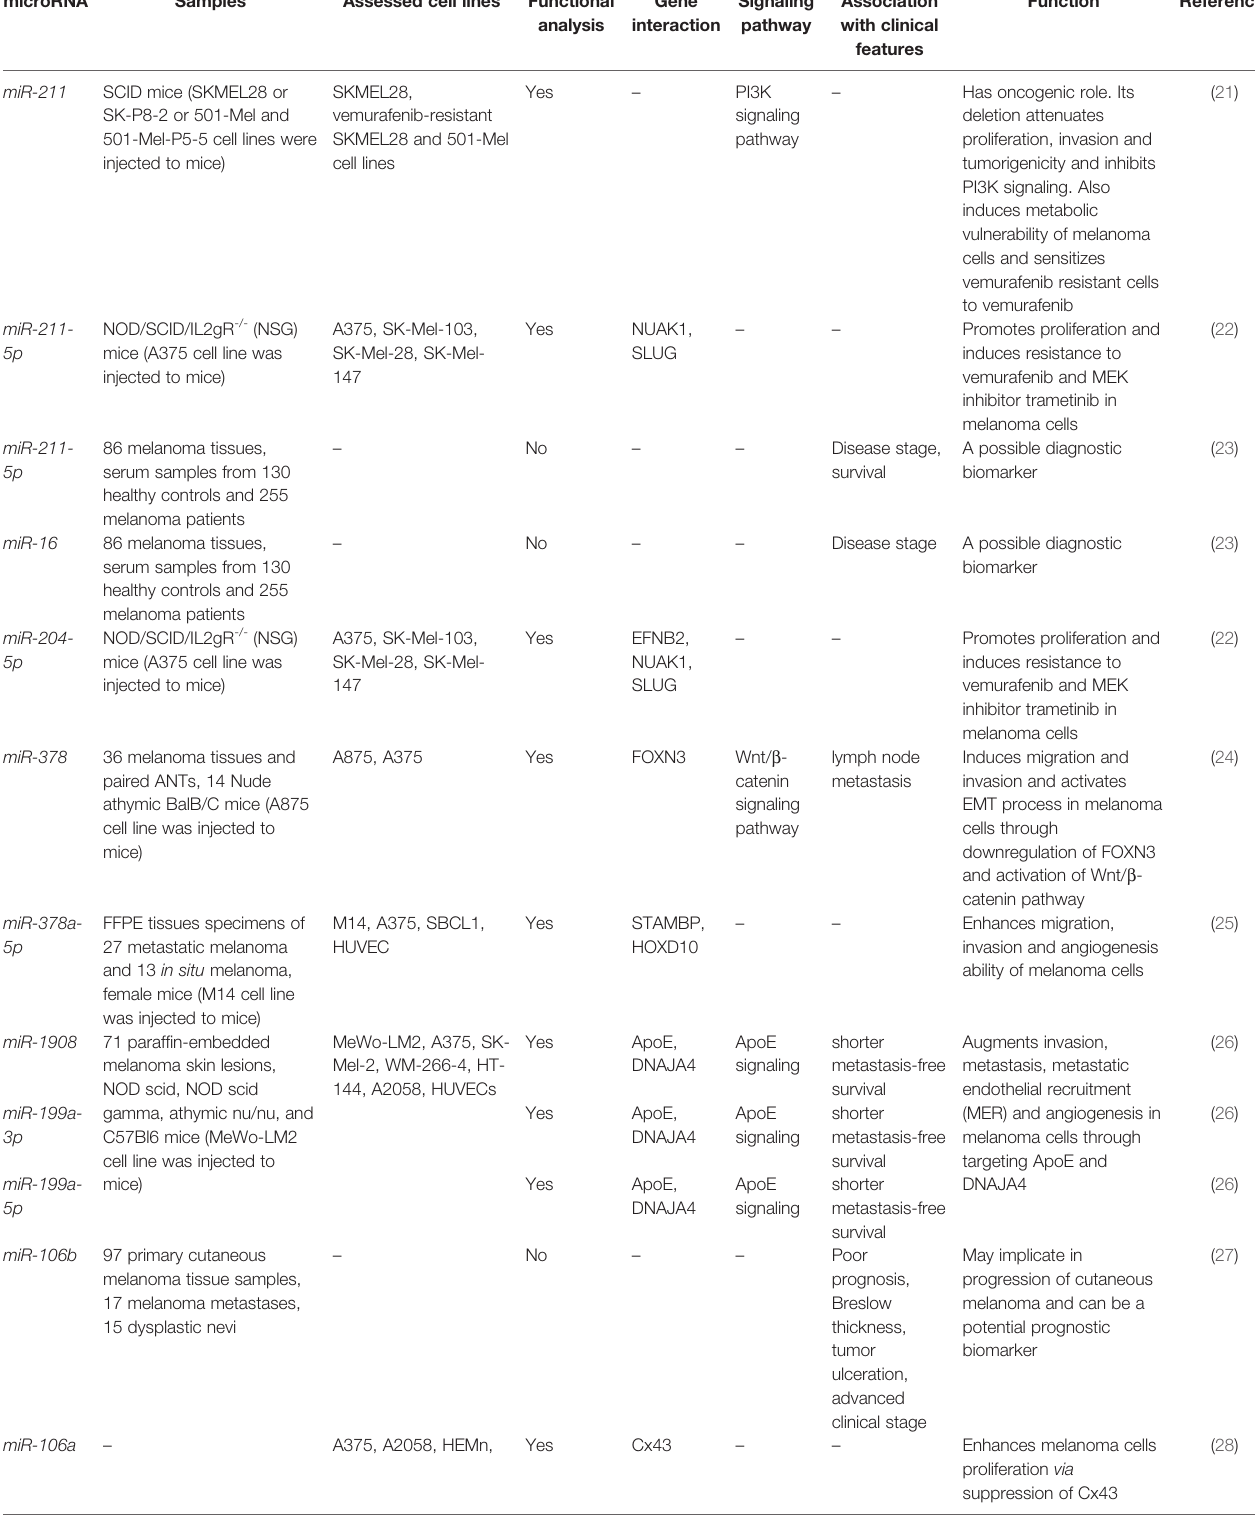
TABLE 1 | List of over-expressed miRNAs in